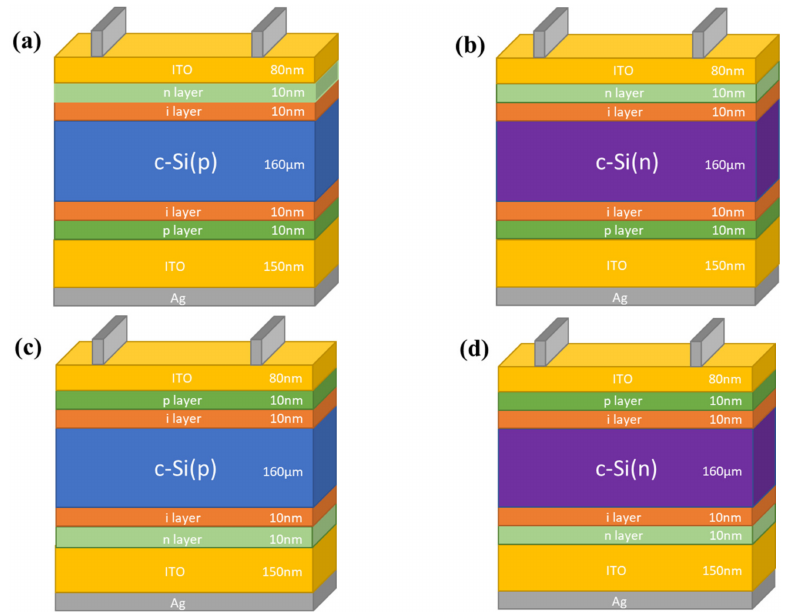
Figure 1. Schematic structure of HIT solar cells. ( a ) p-Type wafer with n-i-p structure (front-emitter cell). ( b ) n-Type wafer with n-i-p structure (front-emitter cell). ( c ) p-Type wafer with p-i-n structure (rear-emitter cell). ( d ) n-Type wafer with p-i-n structure (rear-emitter